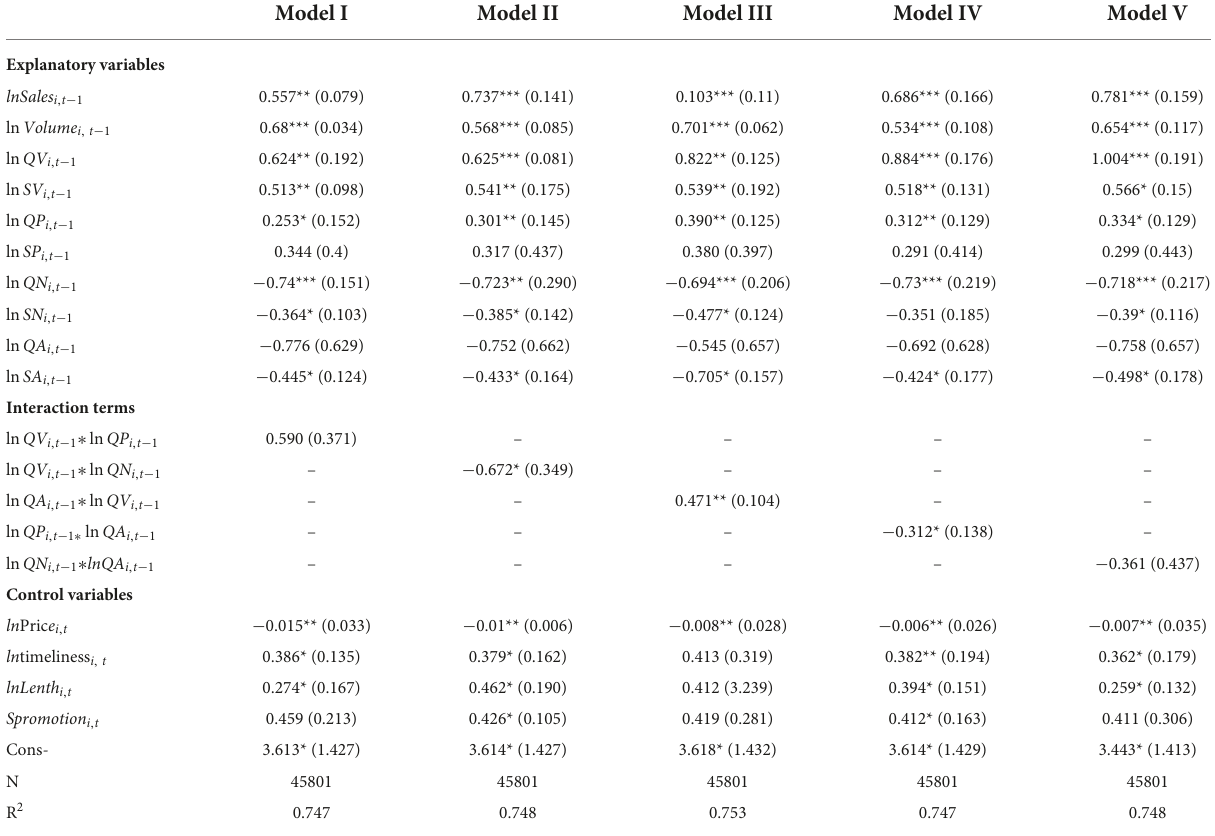
TABLE 6 Regression of interaction effects estimated by two-stage least squares method